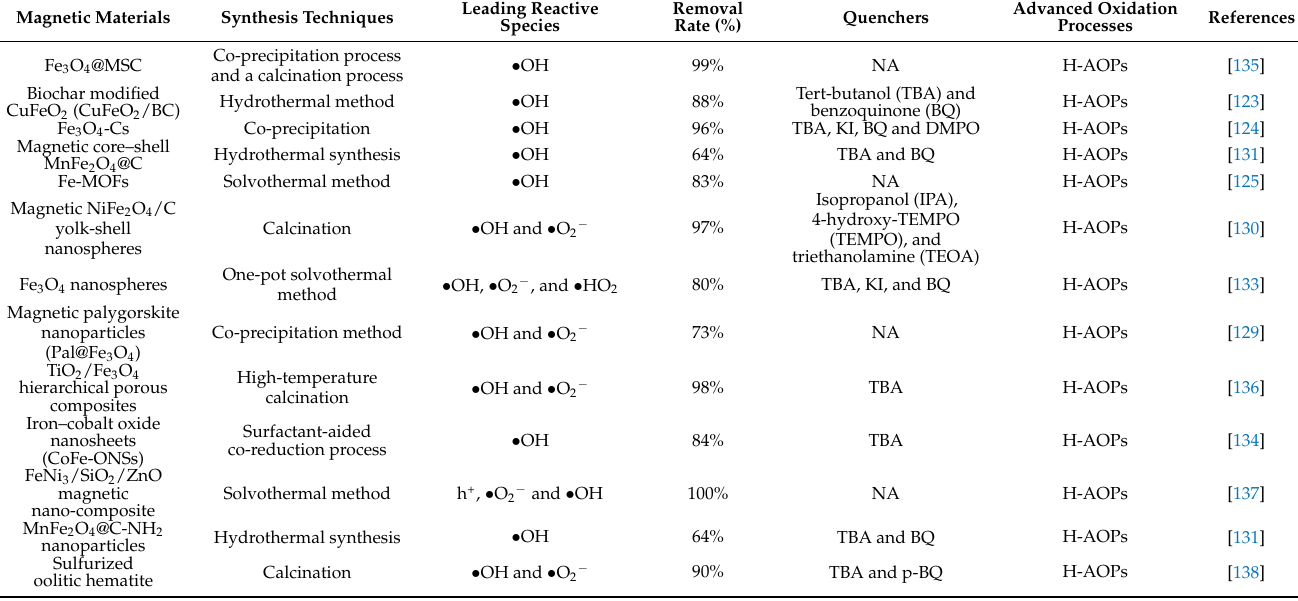
Table 3. Synthesis methods for MCs and their leading reactive species during TC